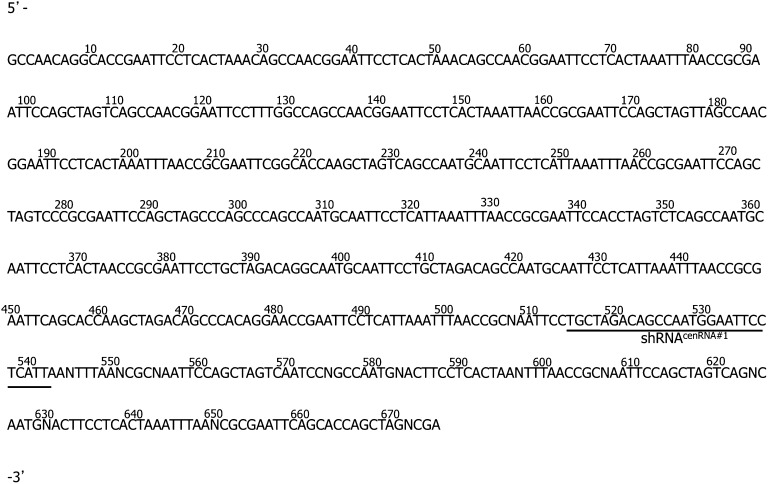
Sequence of cenRNA#1.RNAs immunoprecipitated with CENP-A were retro-transcribed and subcloned. One 675 nucleotide long sequence called cenRNA#1 was obtained by sequencing, and is reported here. The sequence of shRNAcenRNA#1 is underlined.